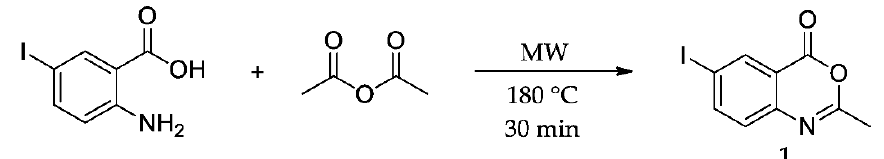
Figure 1. Microwave-assisted synthesis of 6-iodo-2-methyl-4 H -benzo[ d ][1,3]oxazin-4-one.